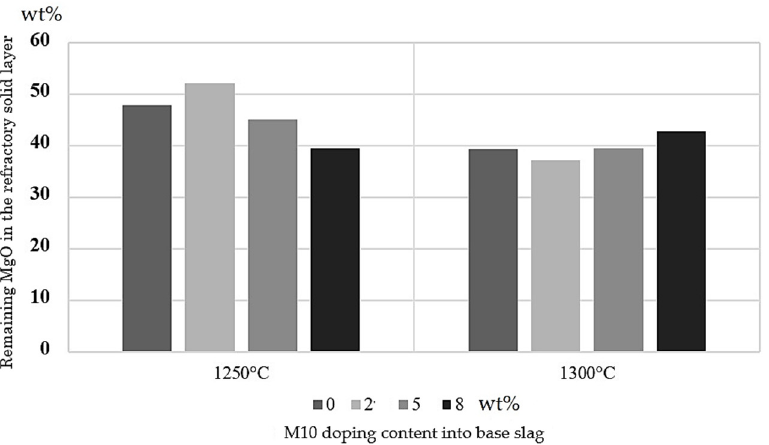
Figure 13. Magnesia content in the solid layer remainder (SLR) on the hot face of the refractory material in contact with M10-doped molten slag at 1250 and 1300 °C, measured by SEM-EDS. At 1300 ◦ C, the lower initial viscosity of the molten slag promoted by the basic oxide from the M10 doping and the higher temperature accelerated the refractory dissolution, as compared with the case at 1250 ◦ C, but only in the infiltrated slag in contact with the hot face of the brick (in a steady-state condition). This decreased the magnesia concentration gradient generated between that zone and the molten slag phase near the